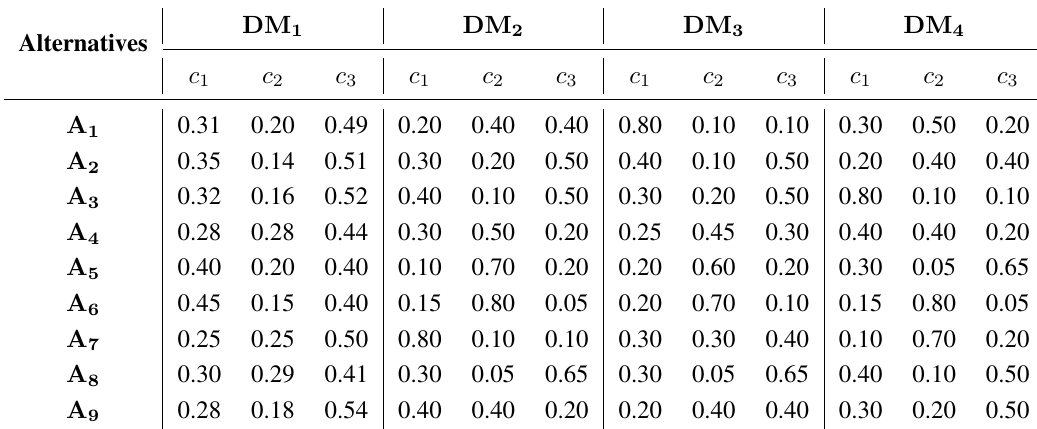
Table 7. Initial score matrices.